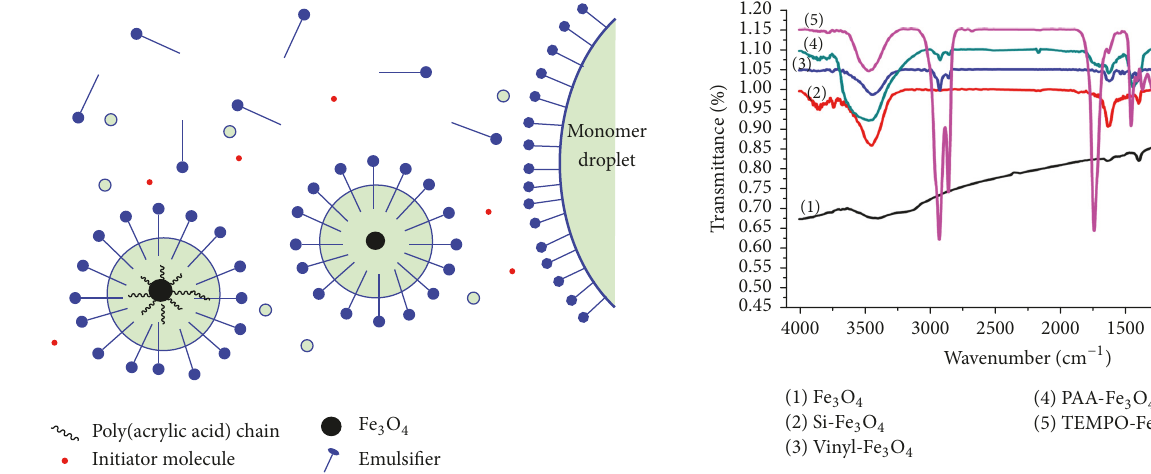
Figure 1: FT-IR spectra of prepared Fe 3 O 4 materials. Table 1: Elemental analysis results and catalyst loading